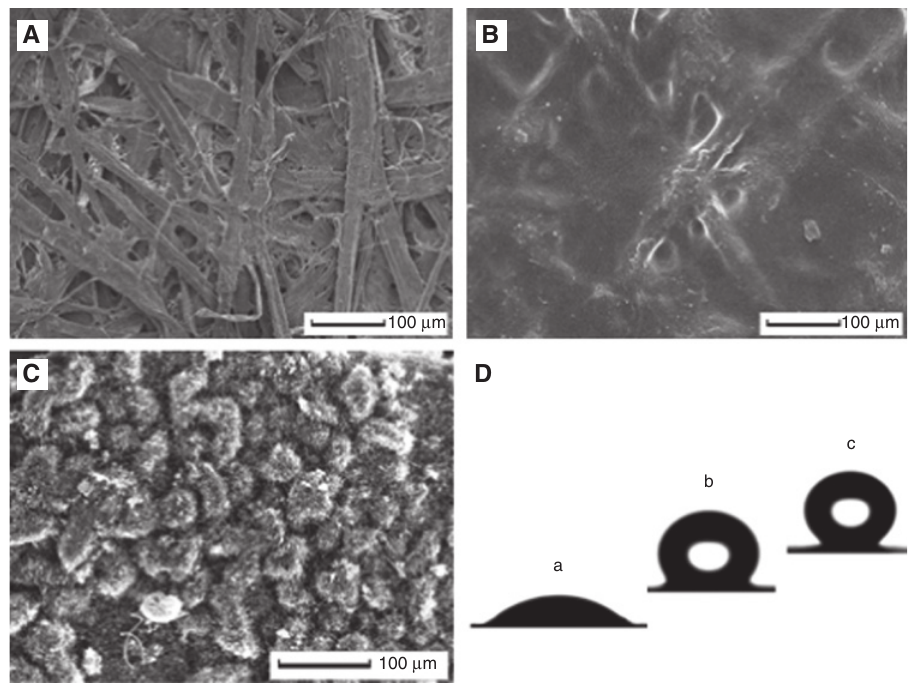
Figure 6: SEM images of (A) uncoated paper, (B) coated paper, (C) etched sample, and (D) water contact angles on their